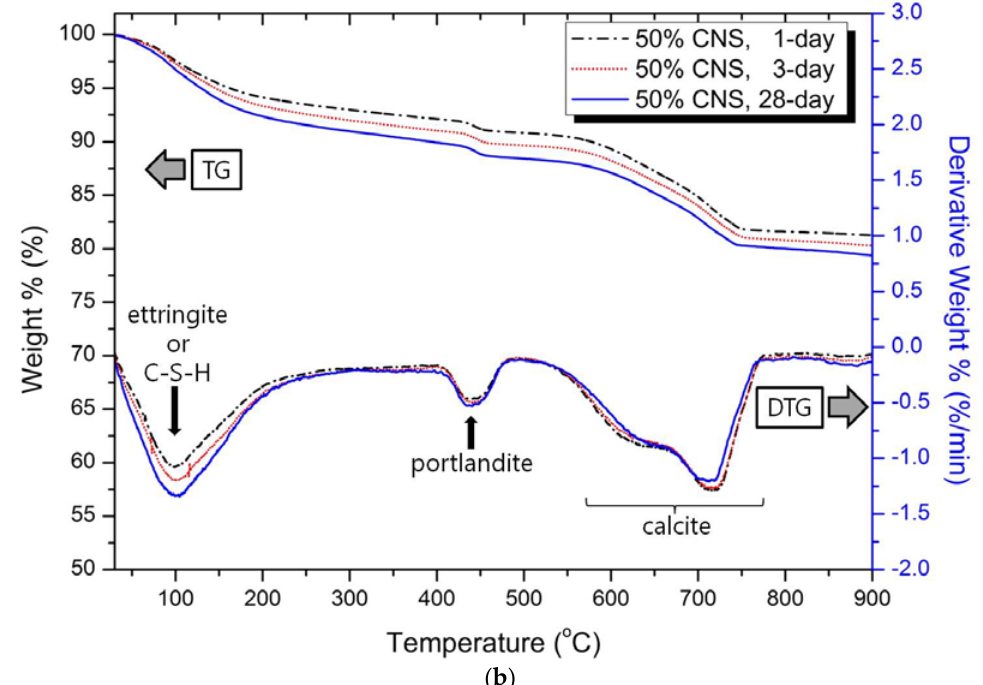
Figure 7. Thermal analysis: ( a ) 0% CNS, ( b ) 50% CNS.